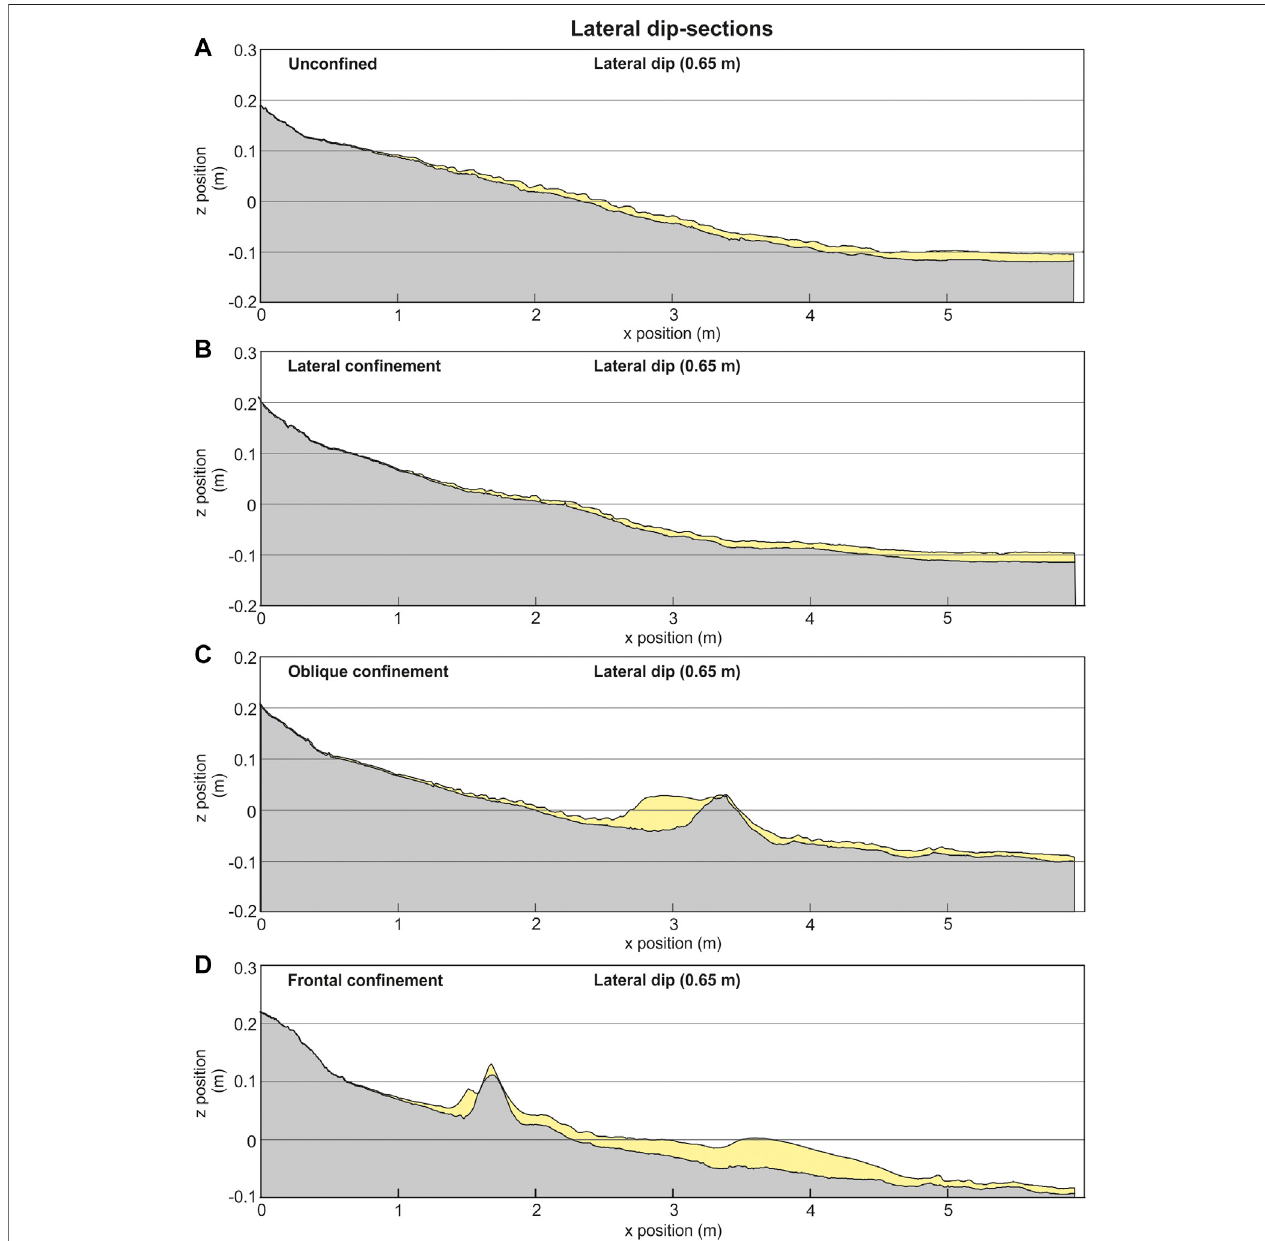
FIGURE 7 | Dip sections through the margin of the deposits. Section location on Figure 3 . Striped pattern indicates erosion.